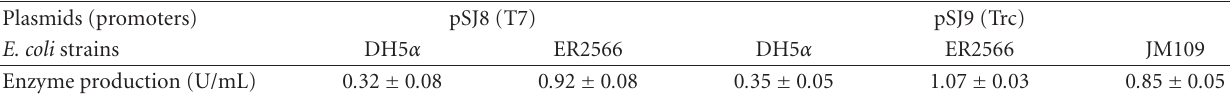
Table 1: E ff ect of the association promoter/host strain on the production of the active recombinant US132 CGTase. Plasmids (promoters) pSJ8 (T7) Enzyme production (U/mL)